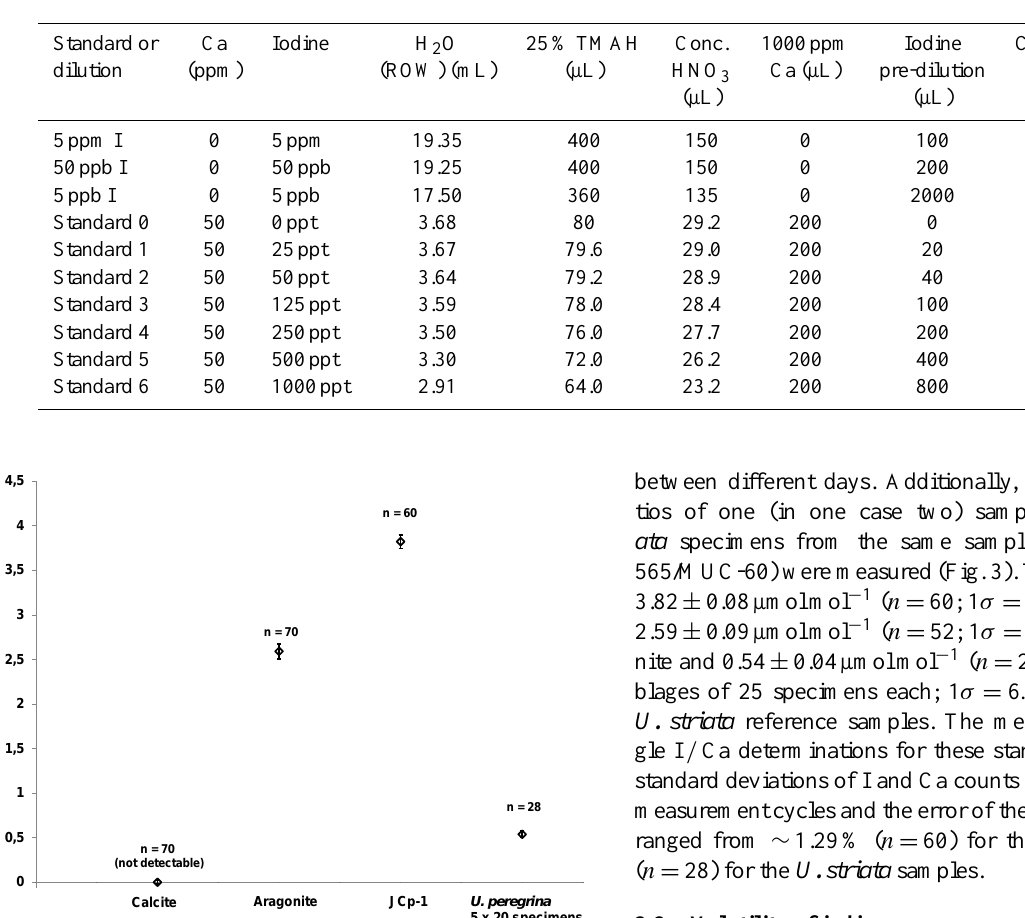
Table 4. Element concentrations and volumes of different pre-dilutions for the different standard rows used for ICP-MS.